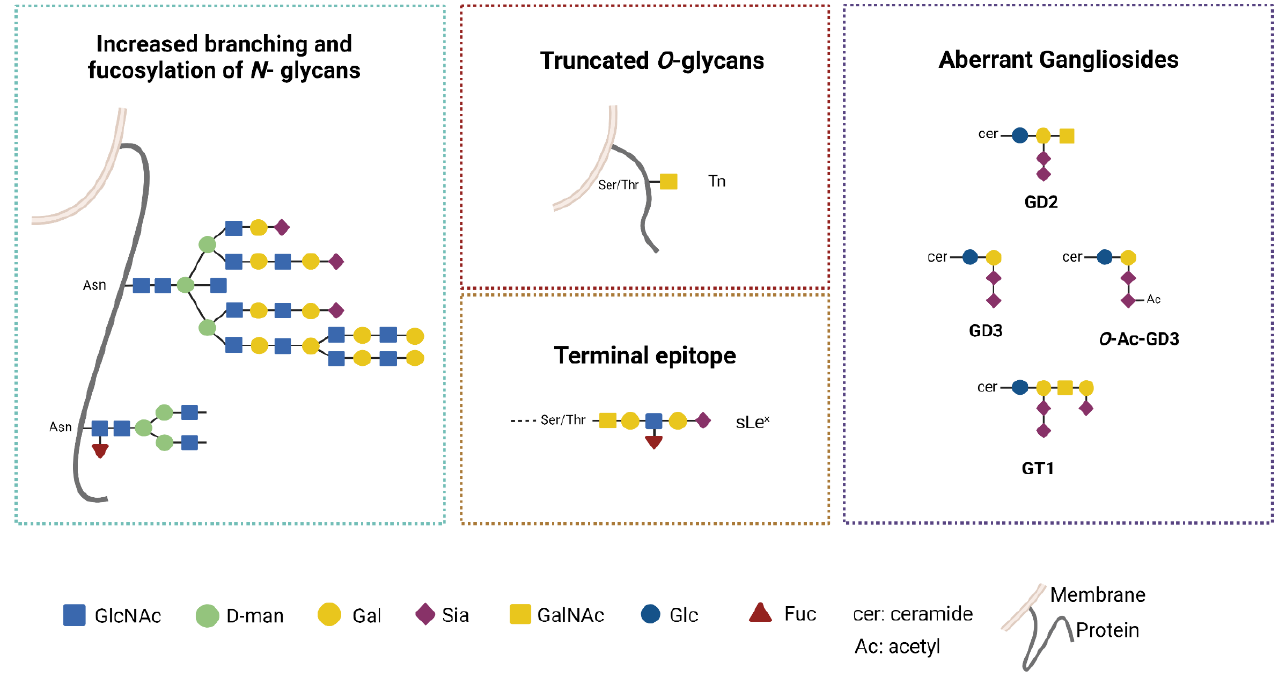
Figure 3. Common altered glycan structures in GB. Glycosylation changes are features of tumorigenesis and sustain tumor progression by affecting several physiological processes. Alterations in N -linked glycosylation, such as increased branching to form complex/hybrid structures and aberrant fucosylation, are mainly found in GB. Truncated O -glycans (Tn, sTn, T, ST) are typical of carcinomas and only Tn has been detected in GB. Excessive sialylation leads to the generation of Sialyl-Lewis Acid (S-Lewis X). Gangliosides are altered in GB and are enriched in GD2, GD3 and its acetylated form, GT1. Created with